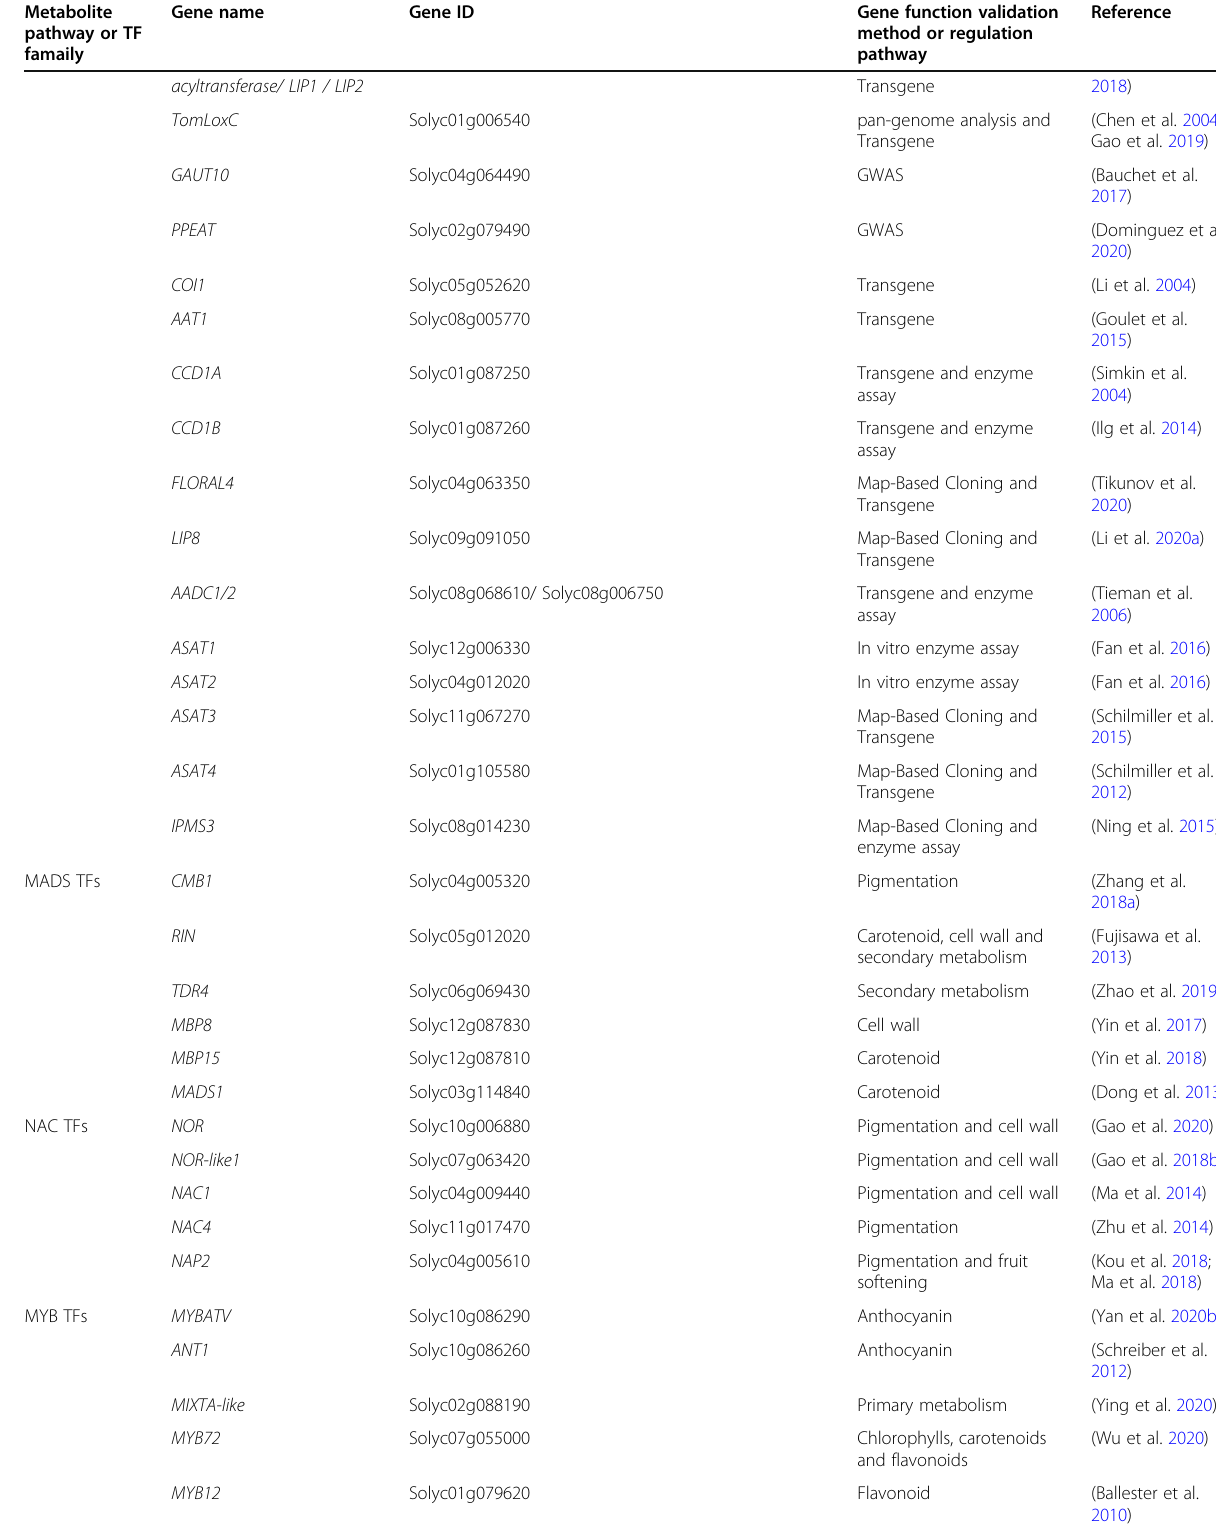
Table 1 Validated structure and transcriptional genes of tomato fruit quality metabolism (Continued) Metabolite pathway or